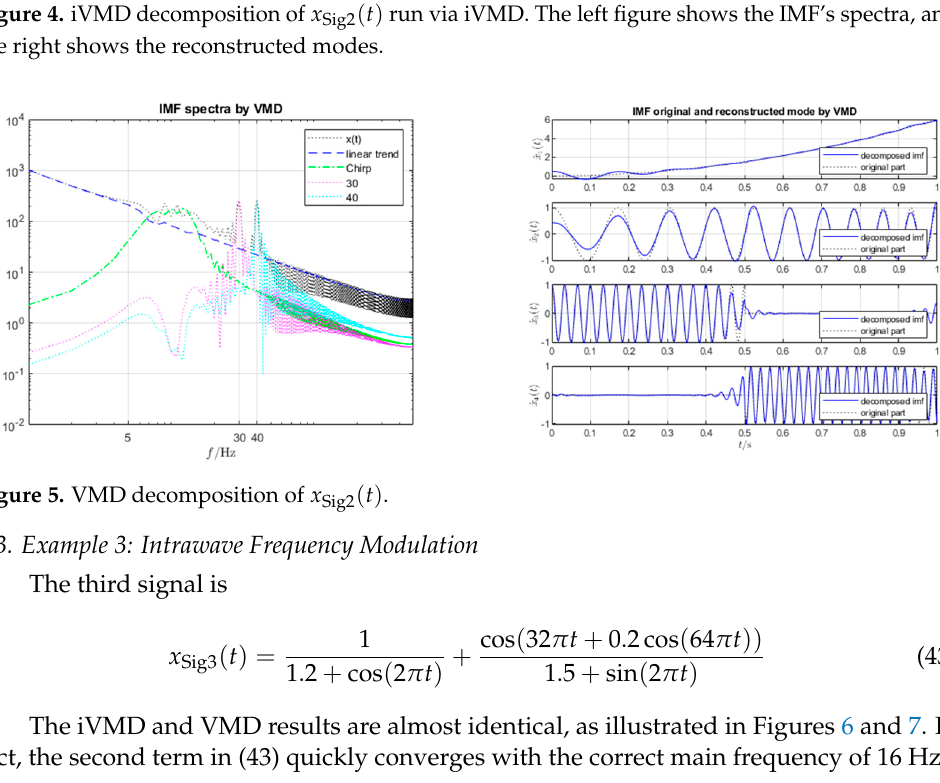
the right shows the reconstructed modes.